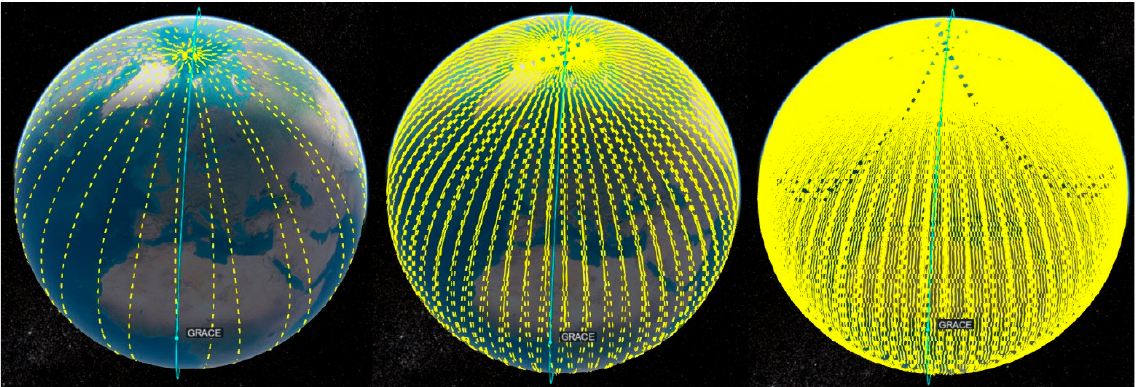
Figure 1. Ground track of the GRACE satellite mission in the periods of 1-day ( Left panel), 1-week ( middle panel), and 1-month ( right panel) (plotted using satellite scenario viewer, Matlab Trial). Different approaches have been proposed to spatially downscale GRACE data. Over